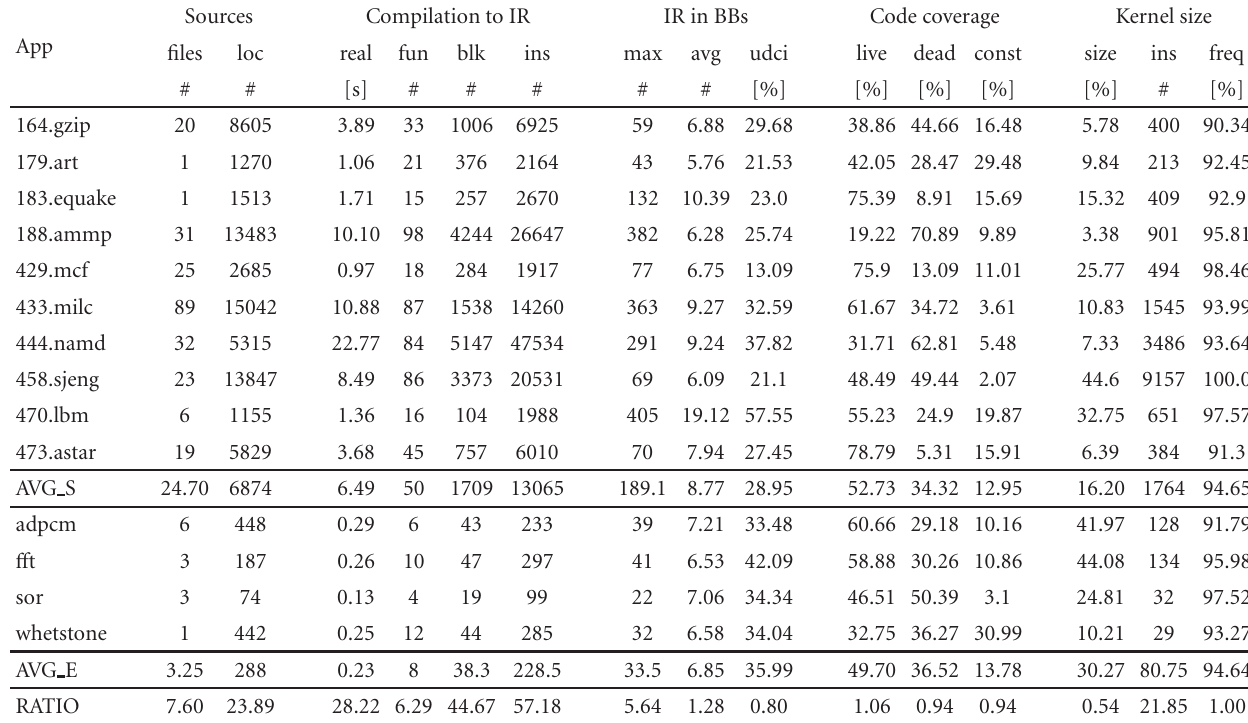
Table 4: Characteristics of scientific and embedded applications. AVG-S represents the averages for scientific applications and AVG-E for the embedded applications. Ratio = AVG-S/AVG-E.